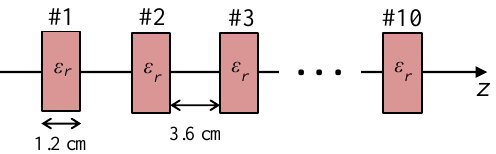
Figure 5: Geometry of the dielectric-stack filter, comprising 10 slabs with stochastic electric